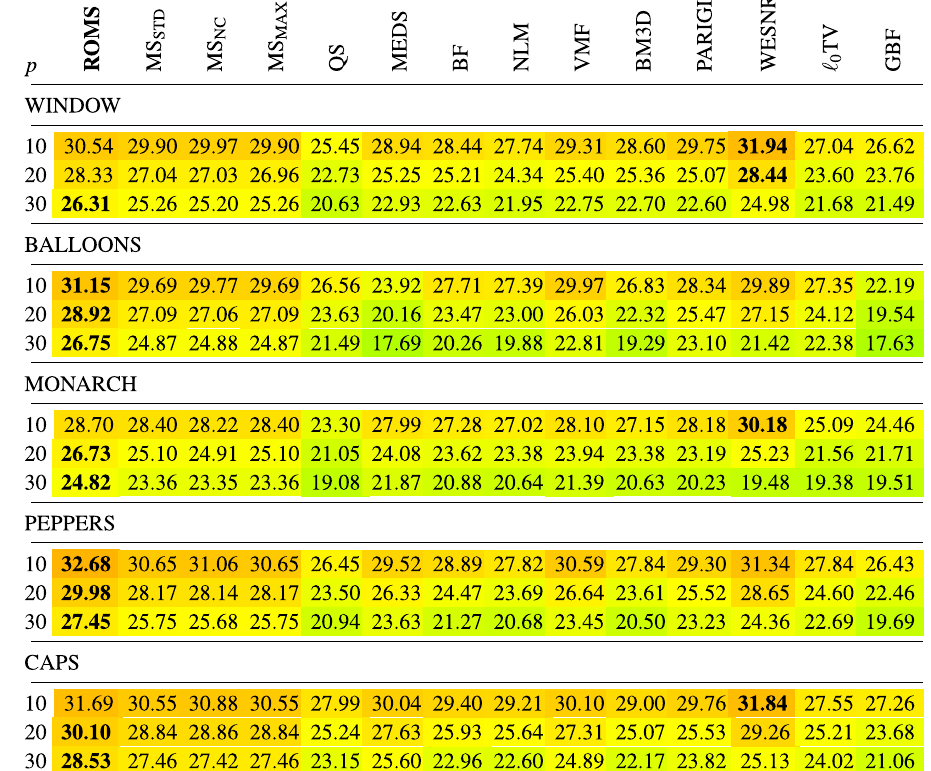
Table 1. Comparison of the PSNR quality measure of the restored color test images contaminated with mixed noise using the new ROMS filter and state-of-the art denoising